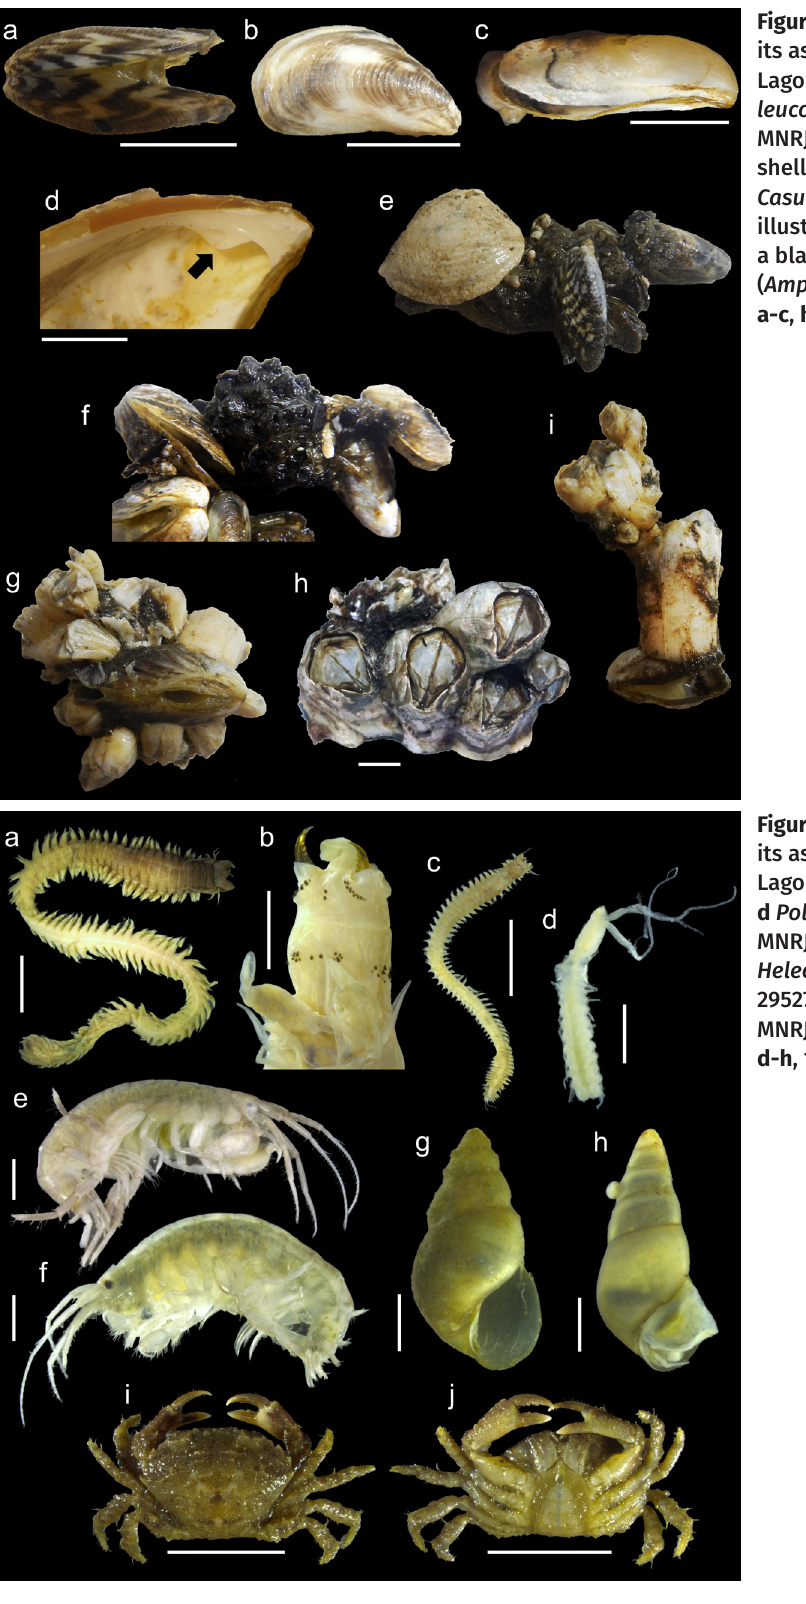
Figure 3. Mytilopsis leucophaeata and its associated fauna in Marapendi Lagoon - 1. a-f Specimens of M . leucophaeata , sampled freely ( a-c MNRJ 29523) or adhered to empty shells of Anomalocardia flexuosa or Casuarina fruits ( e-f MNRJ 29524); d illustrates the apophysis, indicated by a black arrow. g-i Associated barnacles ( Amphibalanus spp.), UFF. Scale bars: a-c , h , 1 cm; d , 3 mm.